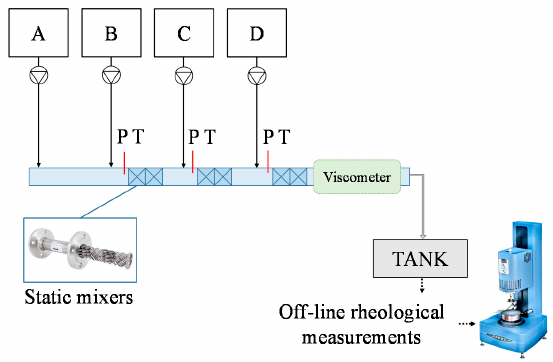
Figure 1. Scheme of the pilot plant at Brussels Innovation Centre (BIC) (Patent N. US 2013/0225468 A1). An in-line Endress-Hauser Proline Promass 83I Coriolis flowmeter, located in the main